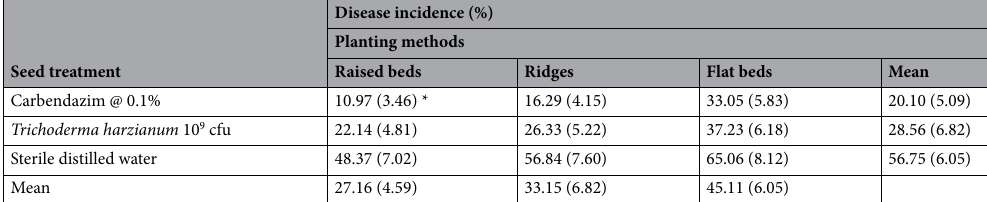
Table 4. Effect of seed treatment and planting methods on disease incidence (%) of root rot of pea under field conditions. *Figures in parenthesis are square transformed values. C.D ( p ≤ 0.05). Planting method (M): 0.103. Seed treatment (S): 0.103. (M × S): 0.179.